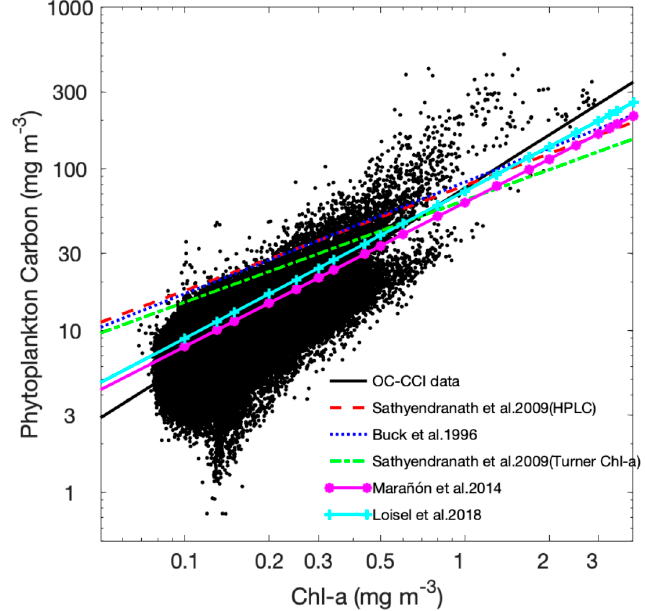
Figure 5. Phytoplankton carbon retrieved with a modified method proposed by Behrenfeld et al. (2005) as a function of Chl-a for monthly mean climatology of satellite data (September 1997 to December 2019) of the South China Sea. The solid black line represents a power law fit to OC-CCI data. For comparison, we also included several empirical fits. The red dashed and blue dash-dotted curves correspond to Sathyendranath et al. (2009) for HPLC and Turner Chl-a, respectively. The other empirical algorithms derived by Buck et al. (1996) (blue dotted line), Mara et al. (2014) (magenta solid line with asterisk symbol), and Loisel et al. (2018) (cyan solid line with plus sign symbol) are also shown.